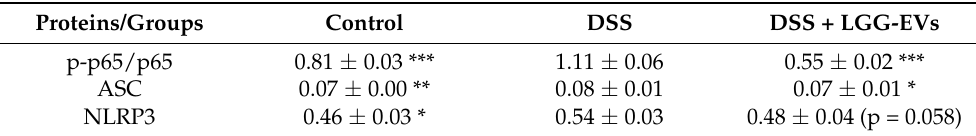
Table 4. Expression level of proteins in NF- κ B and NLRP3 signaling pathways upon LGG-EVs treatments.